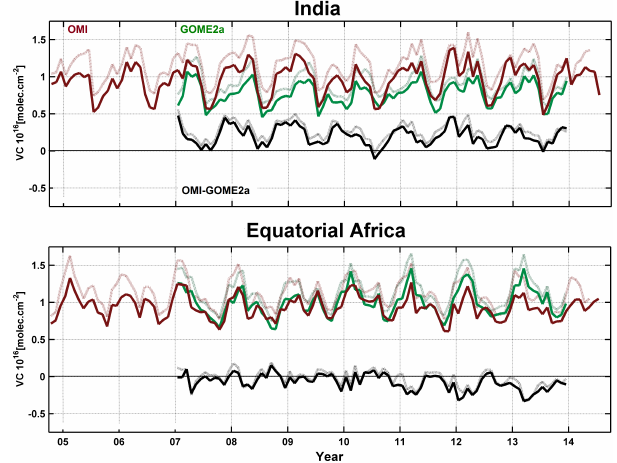
Figure 5. Impact of O 4 on the absolute OMI and GOME-2A H 2 CO columns (respectively in red and green) and on their differences (in black). Dashed lines show results when O 4 is not included in the fits, while solid lines show v14